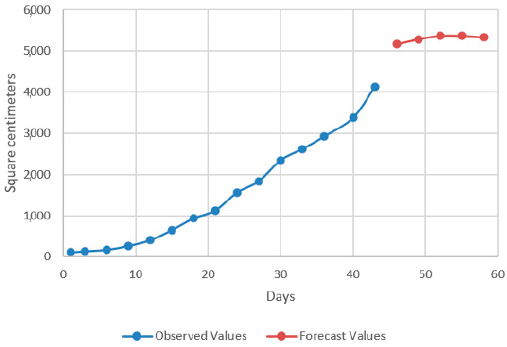
Figure 16. The evolution of basil leaves area in BR experimental variant.